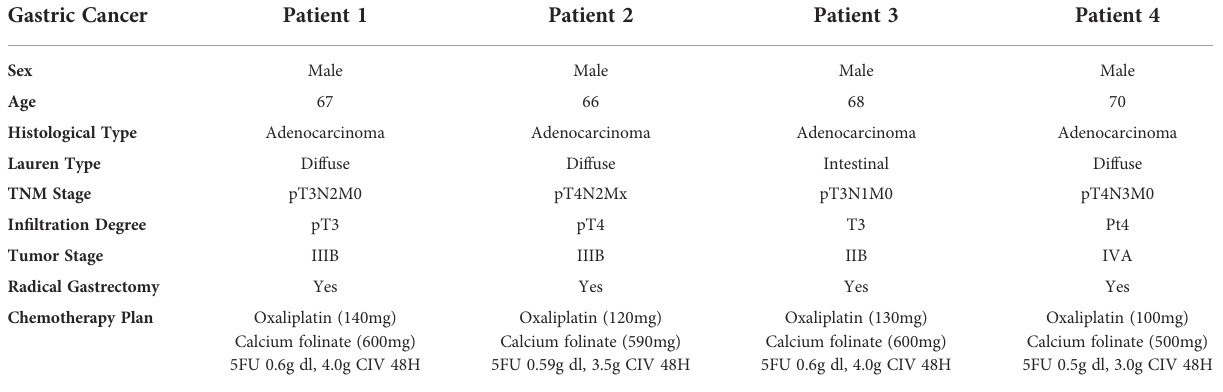
TABLE 2 Clinical information of involved GC